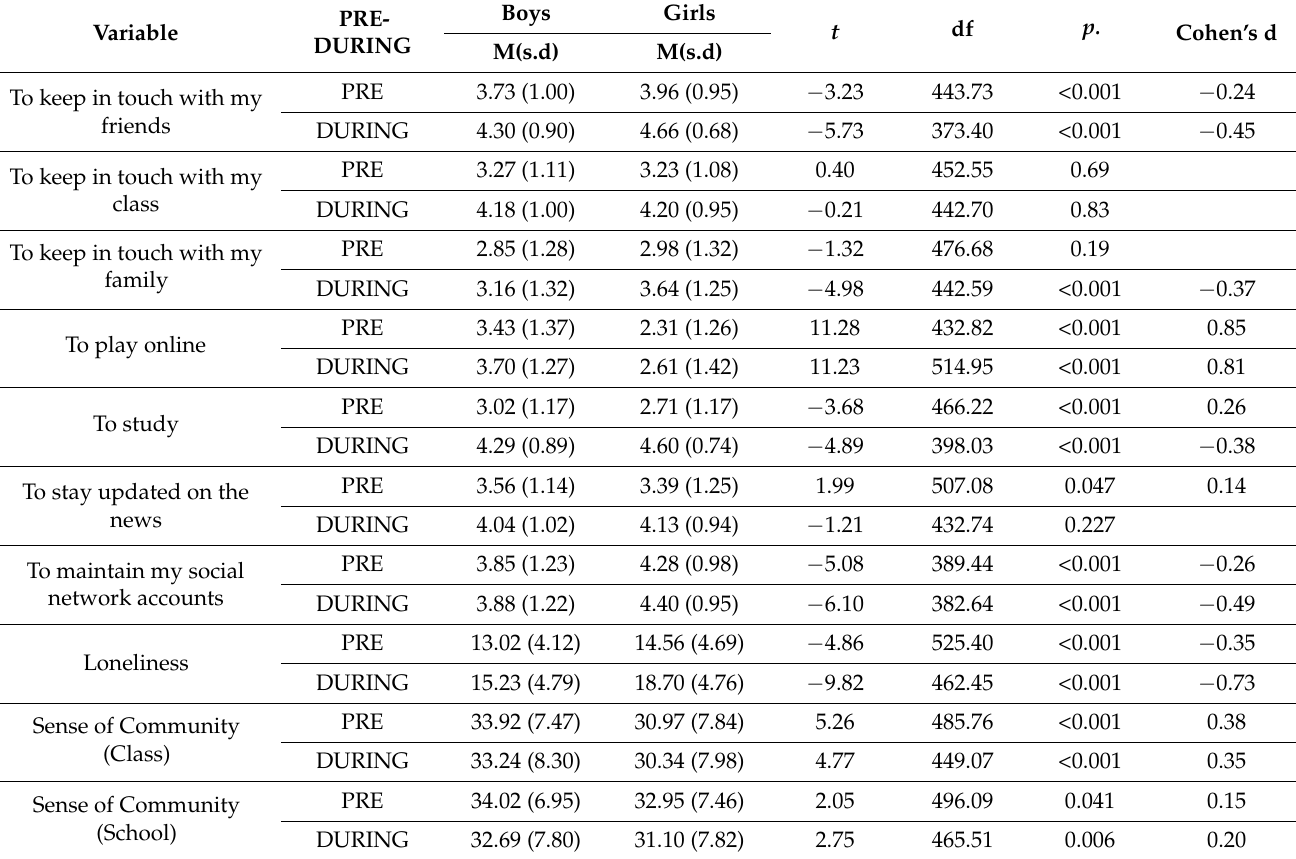
Table 2. Gender-related differences in technology use, SOC, and